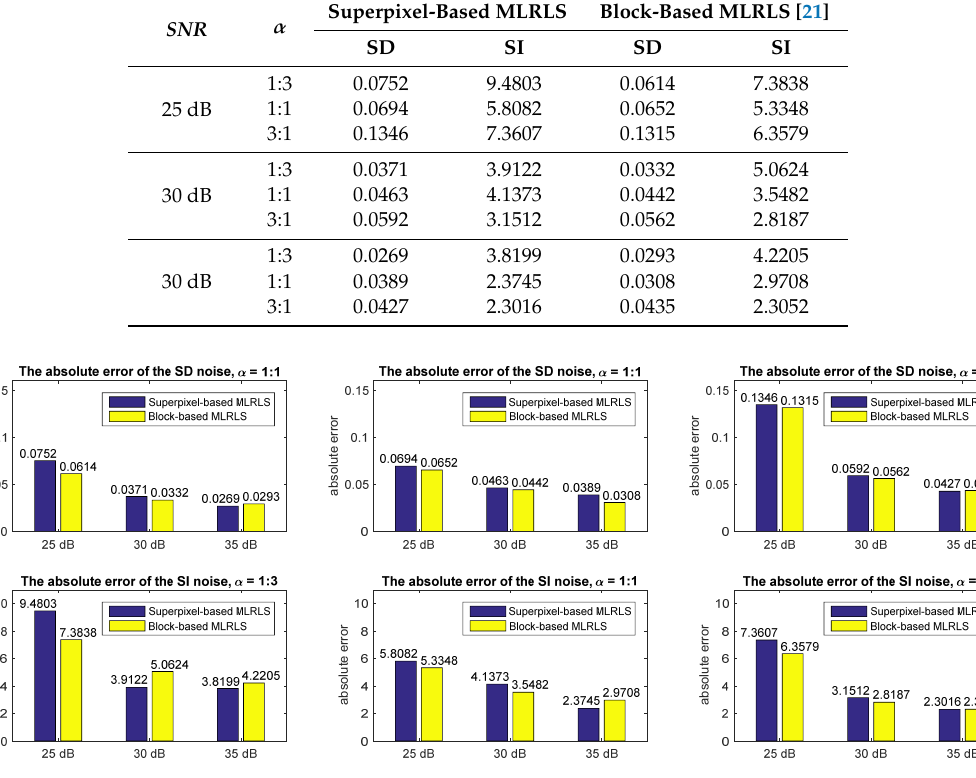
Figure 16. The optimal absolute errors of the SD noise, the SI noise and the concerned optimization for the textured HSI.